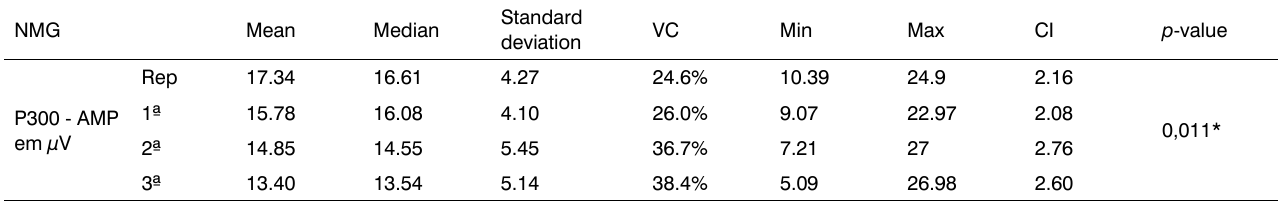
Table 1. p -value amplitude at testing moments in the NMG. NMG